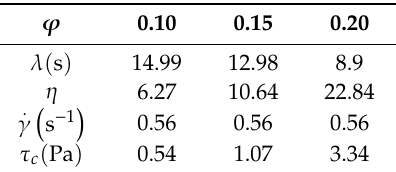
Table A1. Relaxation time ( λ ) as derived from the Carreau fittings in Figure 2c. Viscosity values ( η ) . γ at the specified shear rates ( ) for the estimation of the critical stress values ( τ c ) of the filler silica suspensions investigated in the present